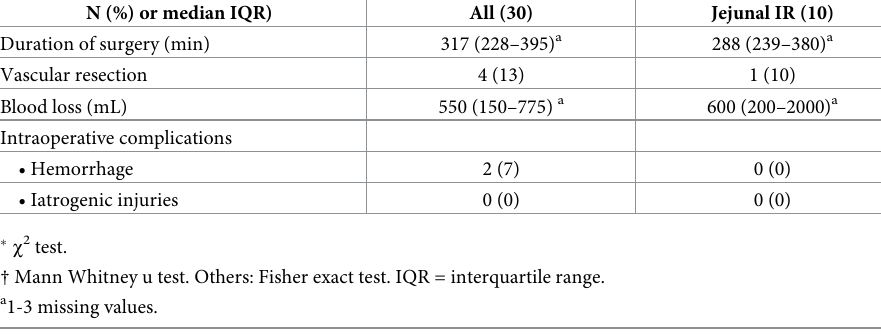
Table 5. Operative data of patients undergoing pancreatic surgery with and without experimental in vivo jejunal IR. N (%) or median IQR)